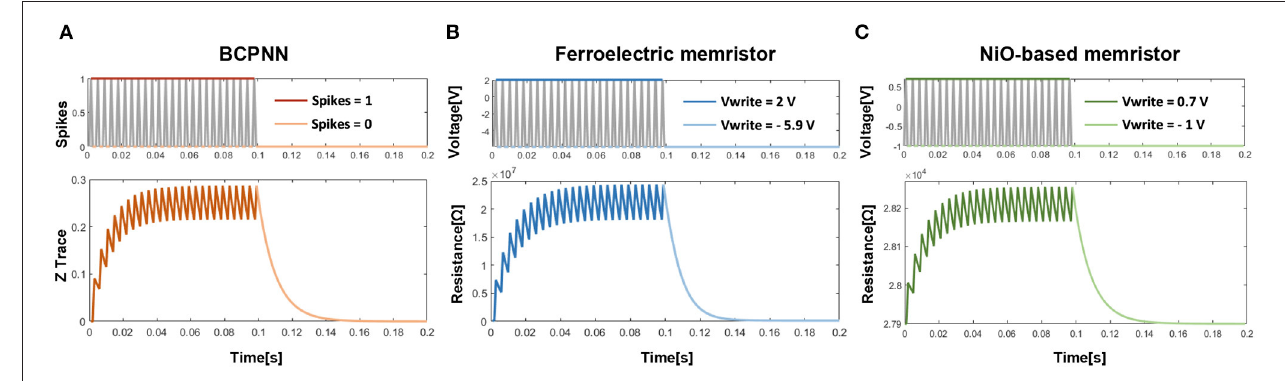
FIGURE 4 | Similarity between the BCPNN trace and the memristor nonlinearity: (A) The curve of Z trace. (B) The curve of resistance of the Ferroelectrc memristor. (C) The curve of resistance of the NiO-based memristor.